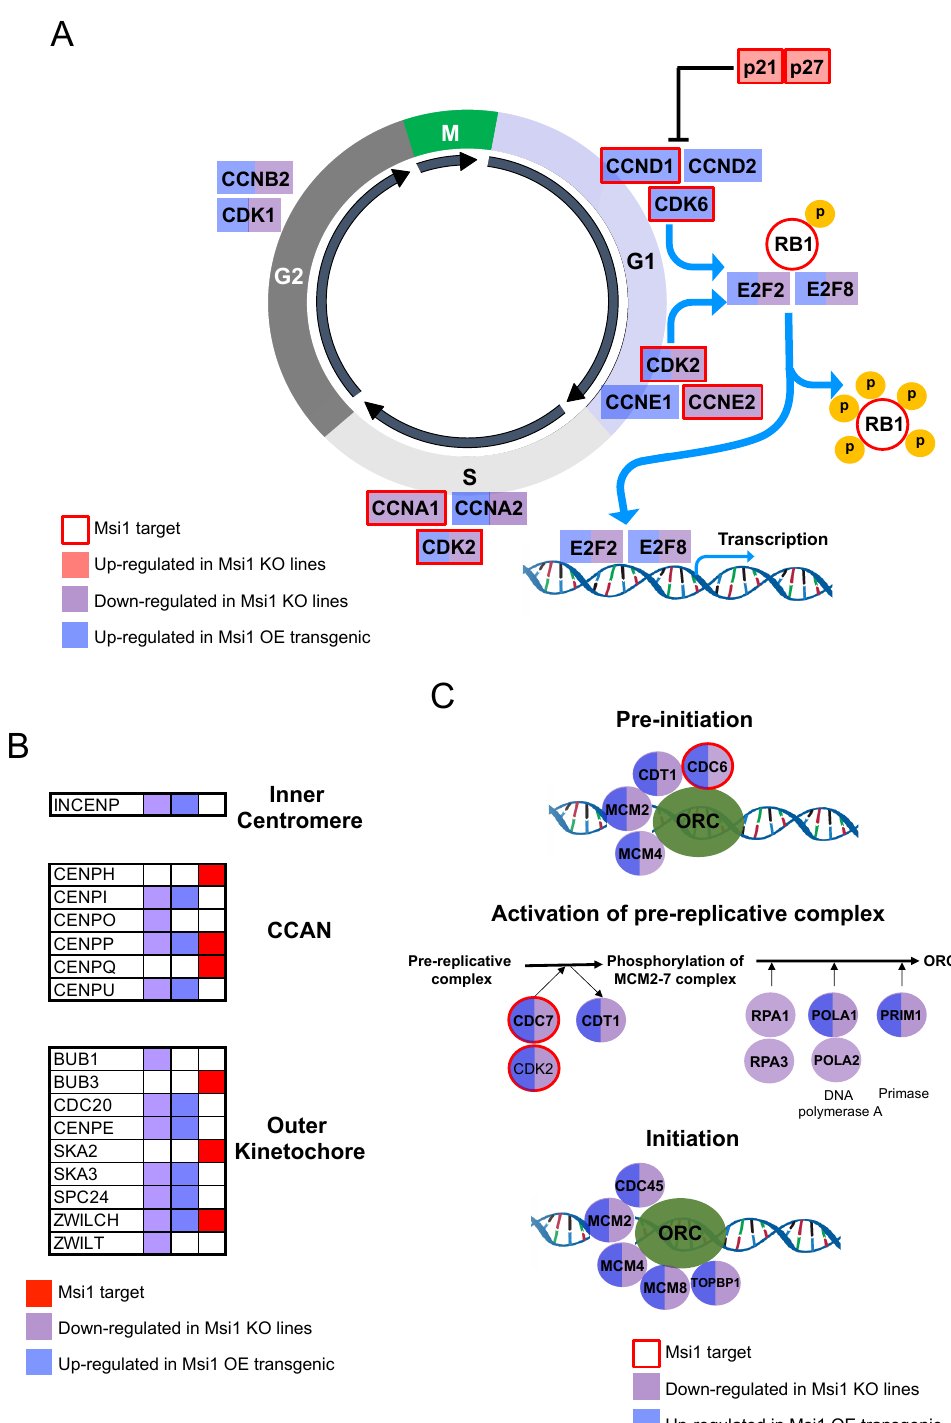
Figure 3. Musashi1 in cell cycle, cell division and DNA replication. ( A ) Cell cycle genes regulated by Msi1 according to different genomic analyses. ( B ) Important genes associated with the centromere that are regulated by Msi1 according to different genomic analyses. Centromere-associated network (CCAN). ( C ) Core DNA replication genes regulated by Msi1 according to different genomic analyses in the pre-initiation, activation of pre-replicative complex and initiation phases of DNA replication. Down-regulated genes in Msi1 KO cells in reference to controls are identified in purple, genes determined to be up-regulated in transgenic tissue with Msi1 OE [21] are identified in blue and Msi1 targets previously identified by CLIP or RIP [3,9,23] are labeled in